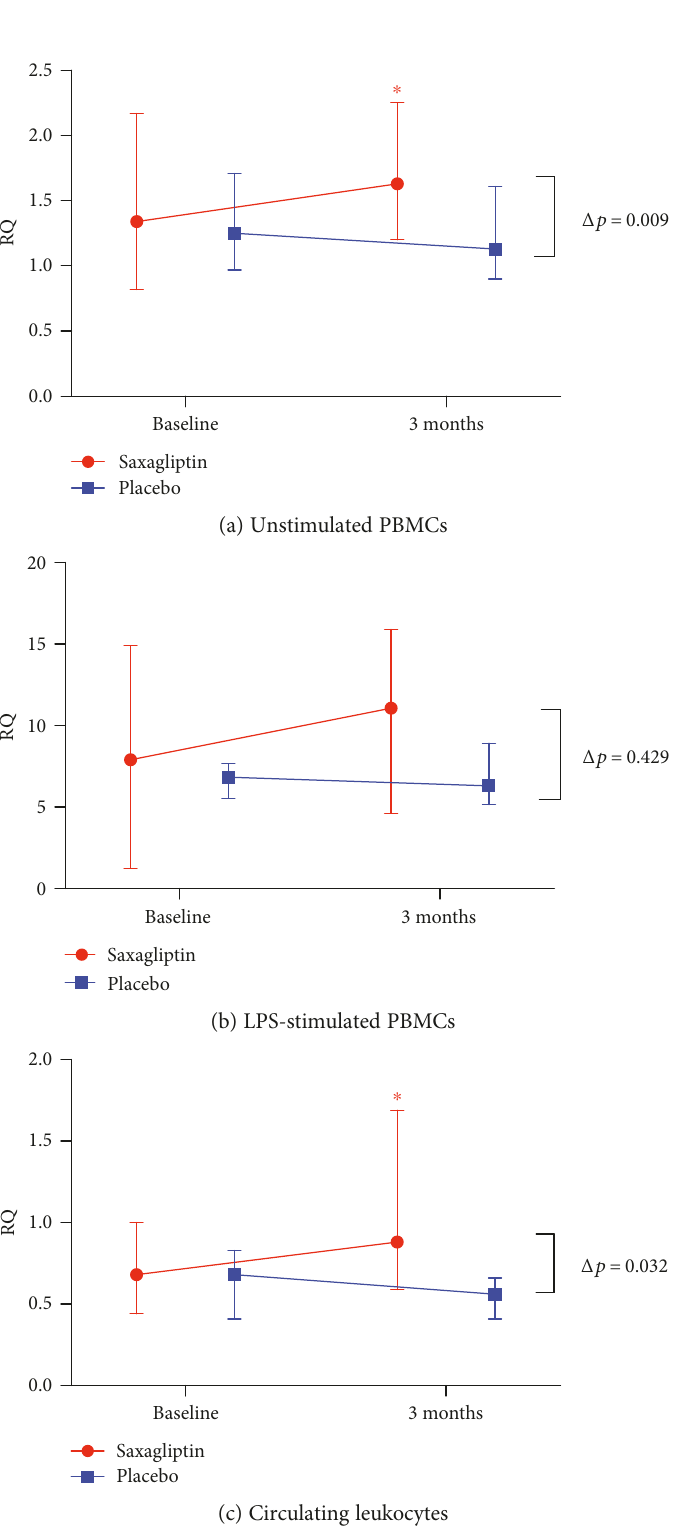
Figure 1: The fi gure shows RQ values of IL-10 from (a) unstimulated PBMCs, (b) LPS-stimulated PBMCs, and (c) circulating leukocytes at baseline and after 3 months in the two randomized groups. The median values are given, with 25 and 75 percentiles depicting the spread. Δ p denotes relative di ff erences in change between the groups. ∗ depicts signi fi cant intragroup change in RQ value. p < 0 05 for intragroup di ff erence from baseline to 3